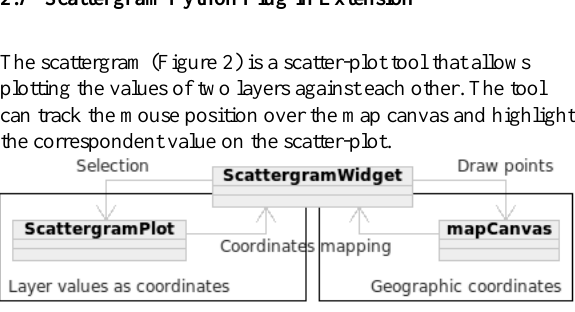
Figure 2. High level architecture of plotToMap functionality Scattergram also allows selecting a polygonal region on the map canvas and then highlights all the points included in the selection in the scatter-plot. The PlotToMap extension does exactly the contrary, allowing the user to select point(s) on the scattergram and to have them plotted on the map canvas. Figure 3 shows one combination of the possible interface elements together in a multiple-linked view environment.